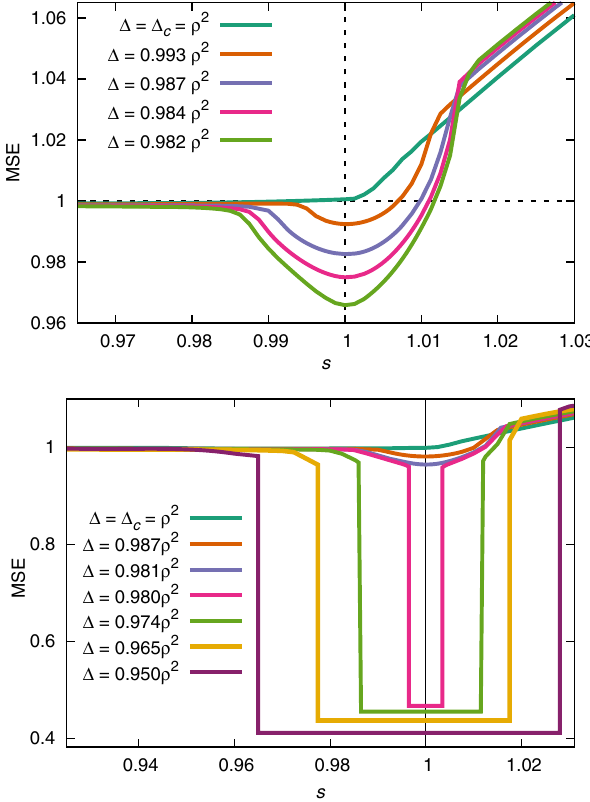
FIG. 3. The MSE as a function of the Parisi parameter s for different values of the noise strength Δ . The smallest MSE is always reached for s ¼ 1 , corresponding to the performance of the AMP algorithm, with a threshold at Δ